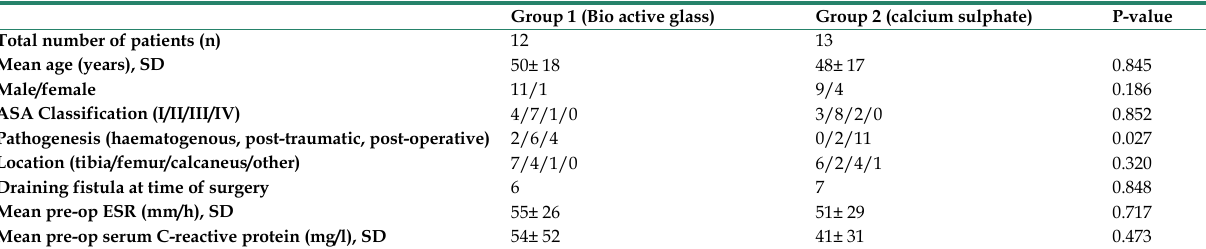
Table 1. Preoperative